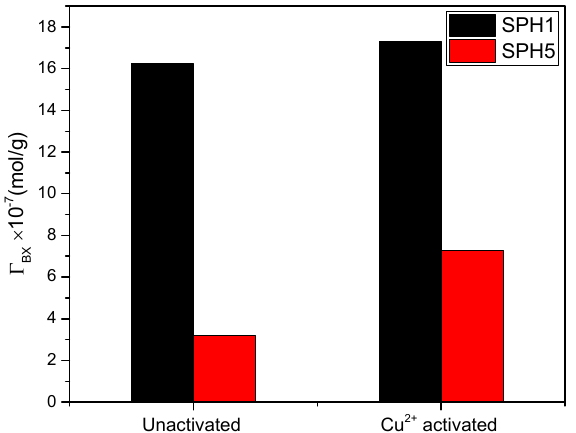
Figure 1. Butyl xanthate (BX) adsorption capacity of sphalerite/marmatite at pH 6.5; concentrations of Cu 2+ and BX were 1 × 10 − 5 and 1 × 10 − 4 mol/L, respectively; the black histogram is for sphalerite (SPH1) and the red histogram is for marmatite